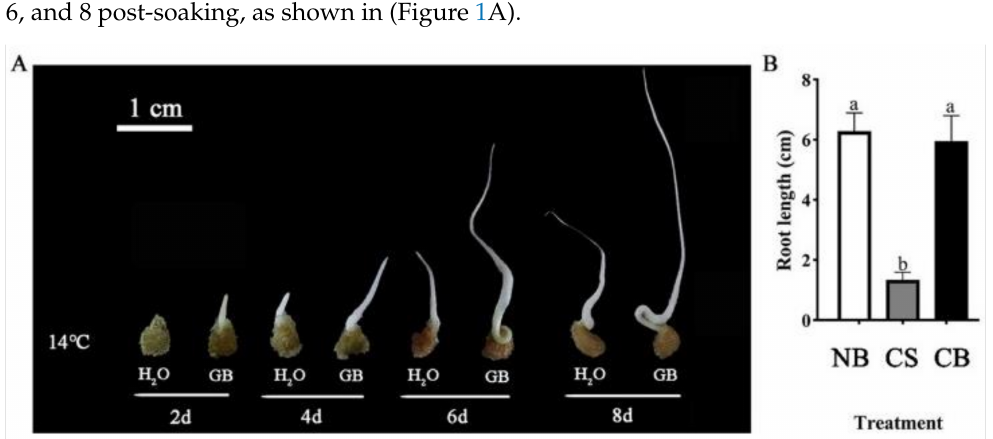
Figure 1. Effects of betaine treatment on tomato seed morphology under low-temperature stress. ( A ) Phenotypes of different treatments at 2, 4, 6, and 8 days. ( B ) Different treatments in seven root lengths. Different lowercase letters indicate significant differences at the 0.05 probability level ( p < 0.05). The vertical bar represents the mean ± standard error of six repeated calculations. NB: seed germination under monohydrate treatment at room temperature; CS: germination of seeds pretreated with just water under 14 ◦ C cold stress; CB: germination of seeds pretreated in 10 mmol/L of GB under 14 ◦ C cold